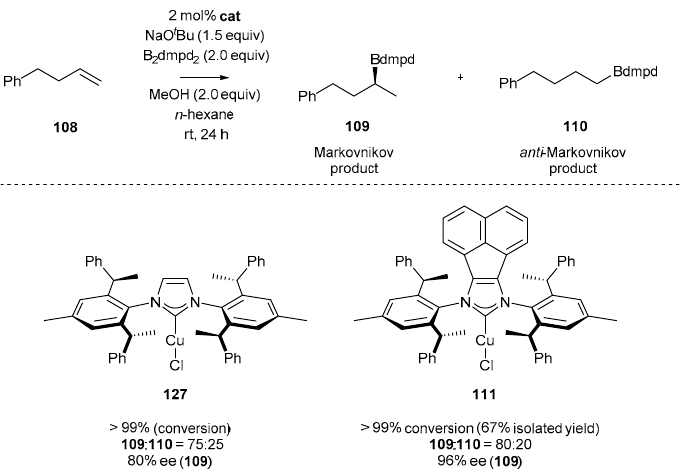
E Figure 4. Comparison of %V bur and steric maps for Ni, Co and Au complexes. Adapted with permission from Ref [52] Diesel, J.; Finogenova, A. M.; Cramer, N. J. Am. Chem. Soc. 2018 , 140 , 4489-4493. Copyright 2021 American Chemical